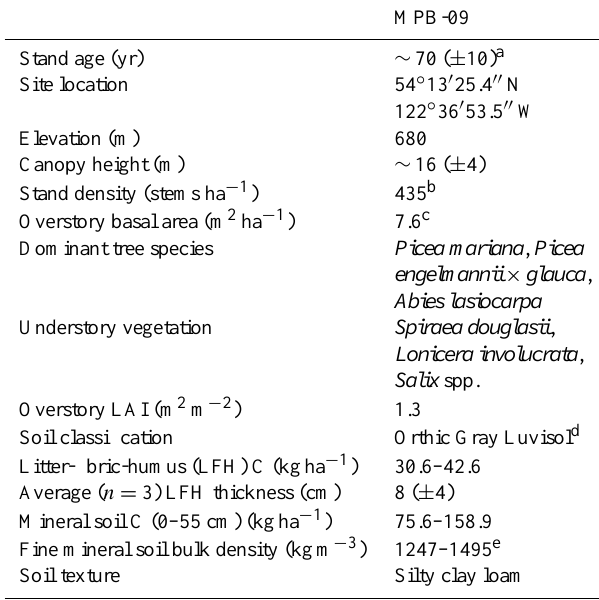
Table 1. Site description for MPB-09 after partial harvesting. Val- ues in parentheses indicate standard deviations ( ± S.D.) from the